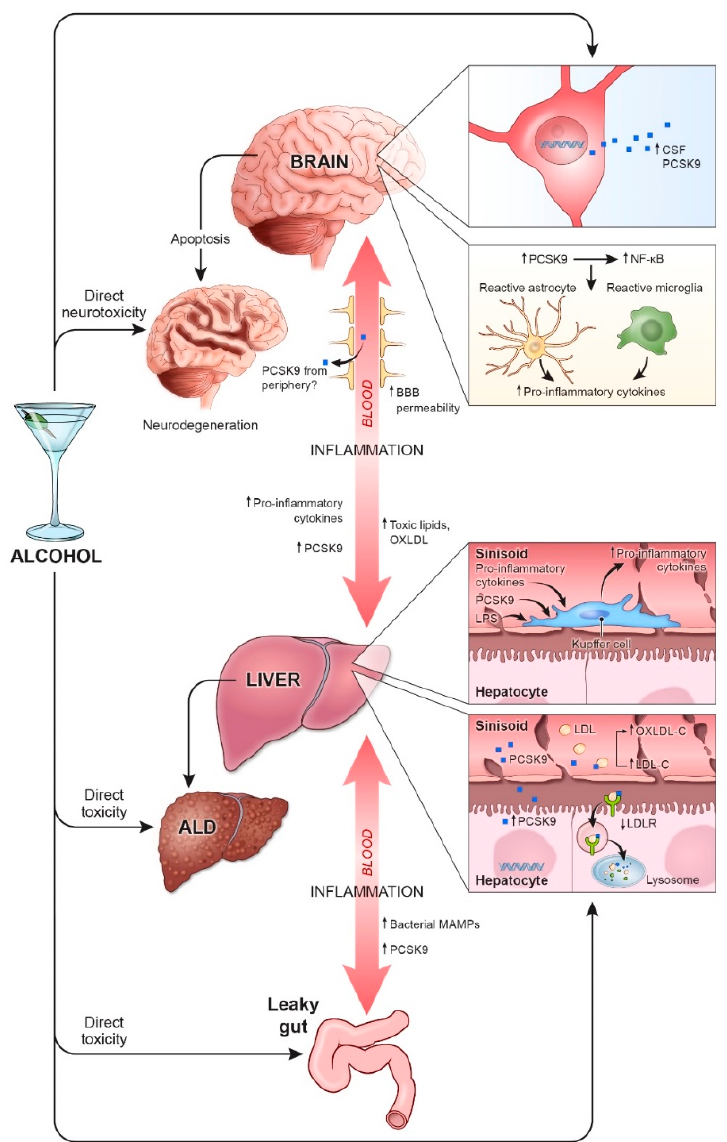
Figure 1. The central role of proprotein convertase subtilisin/kexin type 9 (PCSK9) along the gut-liver-brain axis in alcohol-associated diseases. Alcohol induces brain and liver toxicity and cell death directly and through PCSK9-mediated inflammation. Alcohol is first absorbed in the gut and can disrupt the intestinal barrier integrity, leading to the passage of bacterial microbe-associated molecular patterns (MAMPs) derived from enteric bacterial microbiota into circulation. Dysbiosis in the gut also increases plasma PCSK9 levels. In the liver, alcohol increases PCSK9 protein levels, which leads to increased degradation of low-density lipoprotein receptors (LDLRs) and increased plasma low-density lipoprotein cholesterol (LDL-C) and oxidized low-density lipoprotein cholesterol (oxLDL-C). In addition to alcohol-induced lipopolysaccharides (LPS) and pro-inflammatory cytokines, secreted PCSK9 stimulates Kupffer cells in the liver, which further releases pro-inflammatory cytokines. Elevated levels of PCSK9, pro-inflammatory cytokines, and toxic lipids in the blood promote systemic and neuroinflammation. Plasma PCSK9 leads to increased levels of phosphorylated nuclear factor kappa B (NF κ B) and reactive astrocytes and microglia. These glia release more pro-inflammatory cytokines to further perpetuate this axis of inflammation. Additionally, alcohol directly increases PCSK9 levels in the cerebrospinal fluid (CSF). Note: BBB—blood-brain barrier, oxLDL—oxidized low-density lipoprotein, ALD—alcohol-associated liver